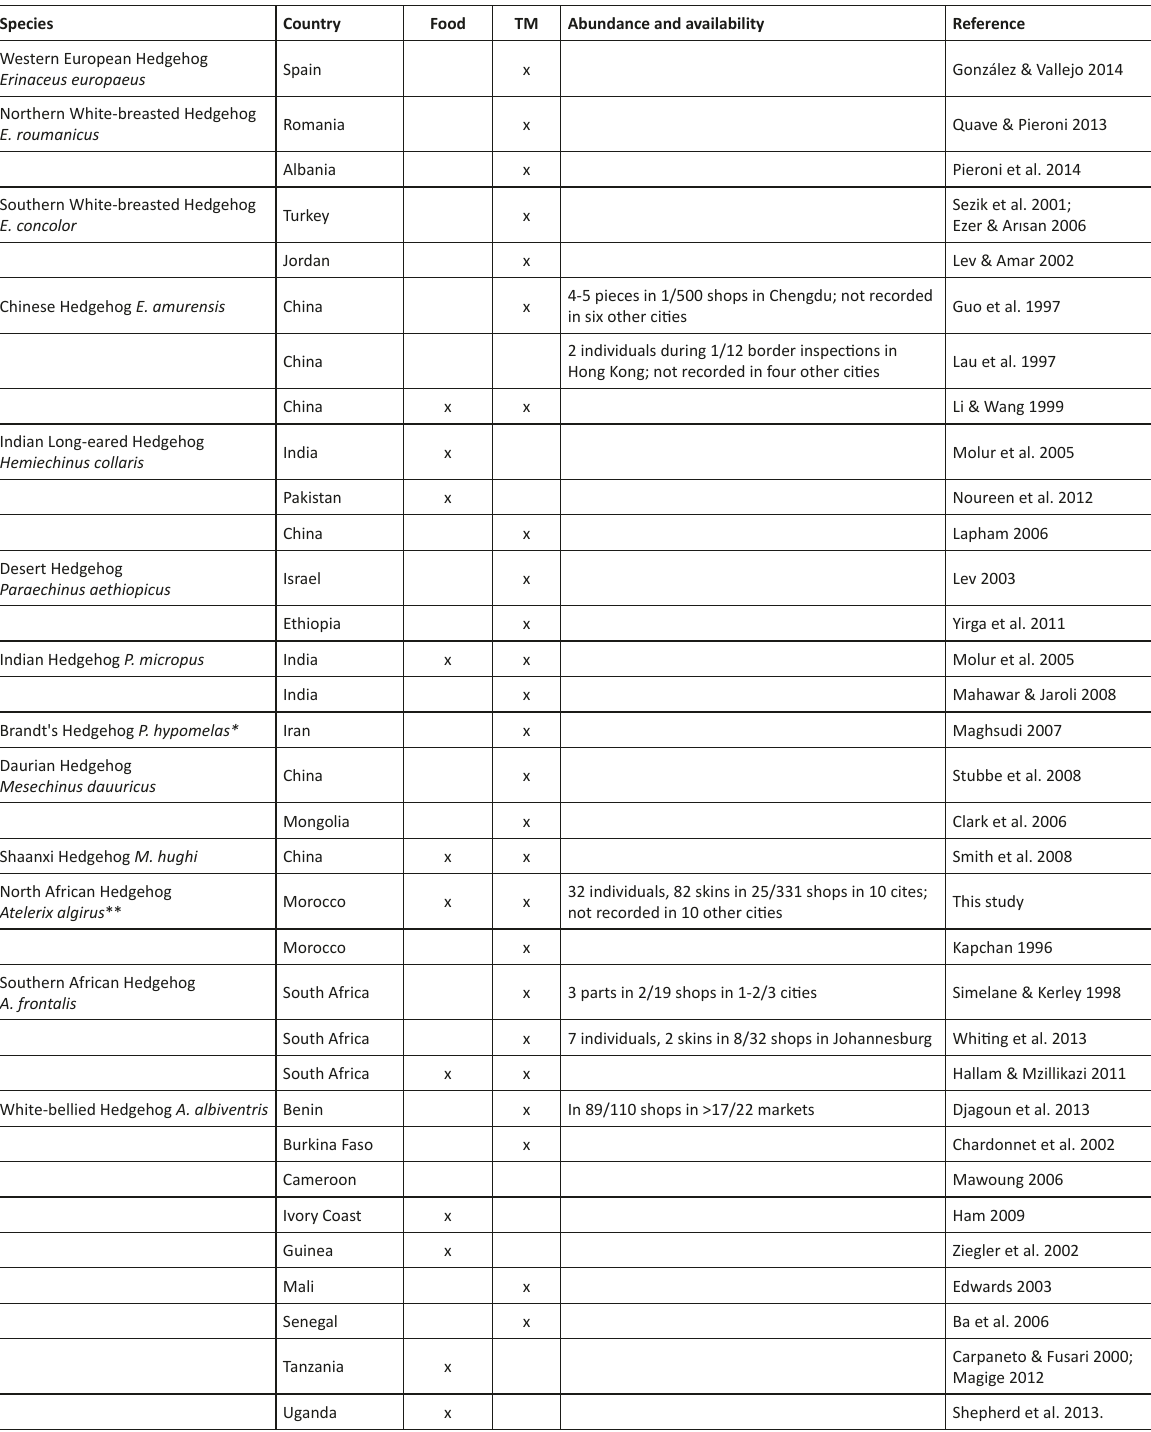
Table 2. Overview of global trade in and use of hedgehogs for food and traditional (‘folk’) medicine (TM); only contemporary studies (post 1995) are included. Most studies were qualitative in nature; for those that were quantitative the abundance and availability of hedgehogs is